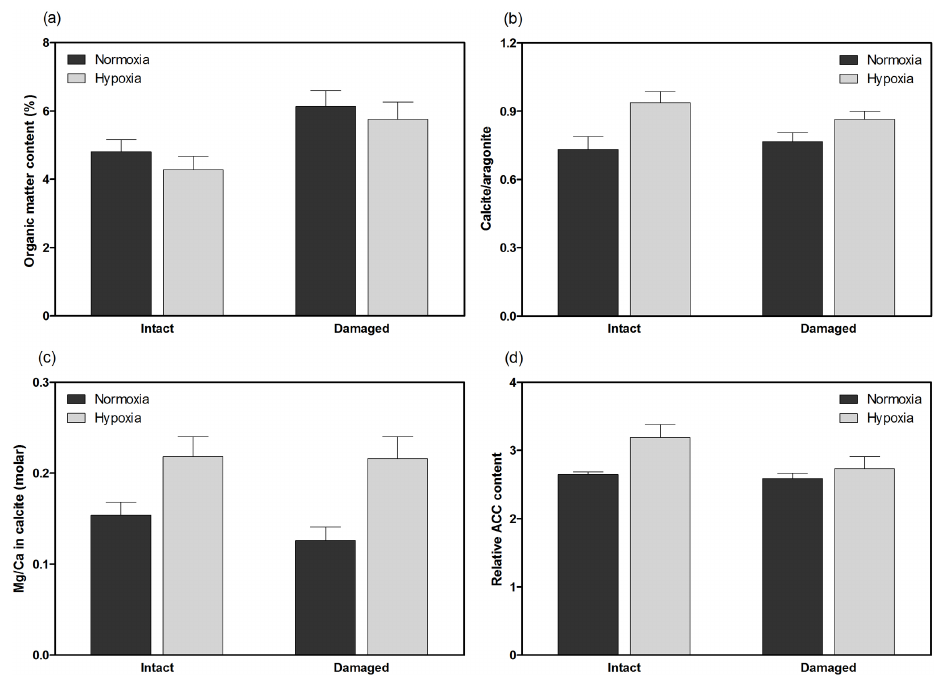
Figure 4. Geochemical properties of H. diramphus shells, including (a) organic matter content, (b) calcite to aragonite ratio, (c) magnesium to calcium ratio in calcite and (d) relative amorphous calcium carbonate content, in different treatments (mean + S.E.; n = 3, except n = 5 for organic matter